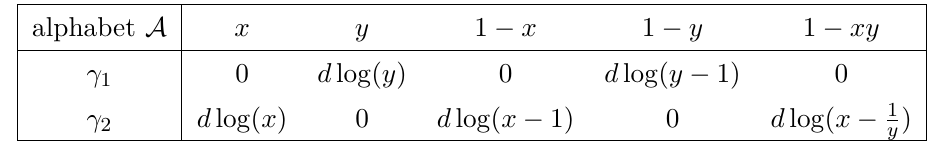
Table 4 . Pull-backs of the d log -forms along the two components of the integration path shown in figure 2. These d log -forms act as the integration kernels in eqs. (3.11), (3.12) and (3.13). Note, that along γ 1 the integration variable is y , and along γ 2 the integration variable is x , while y remains